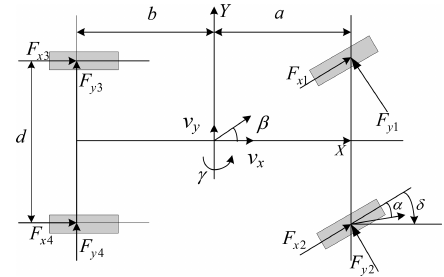
Figure 1. Vehicle dynamics